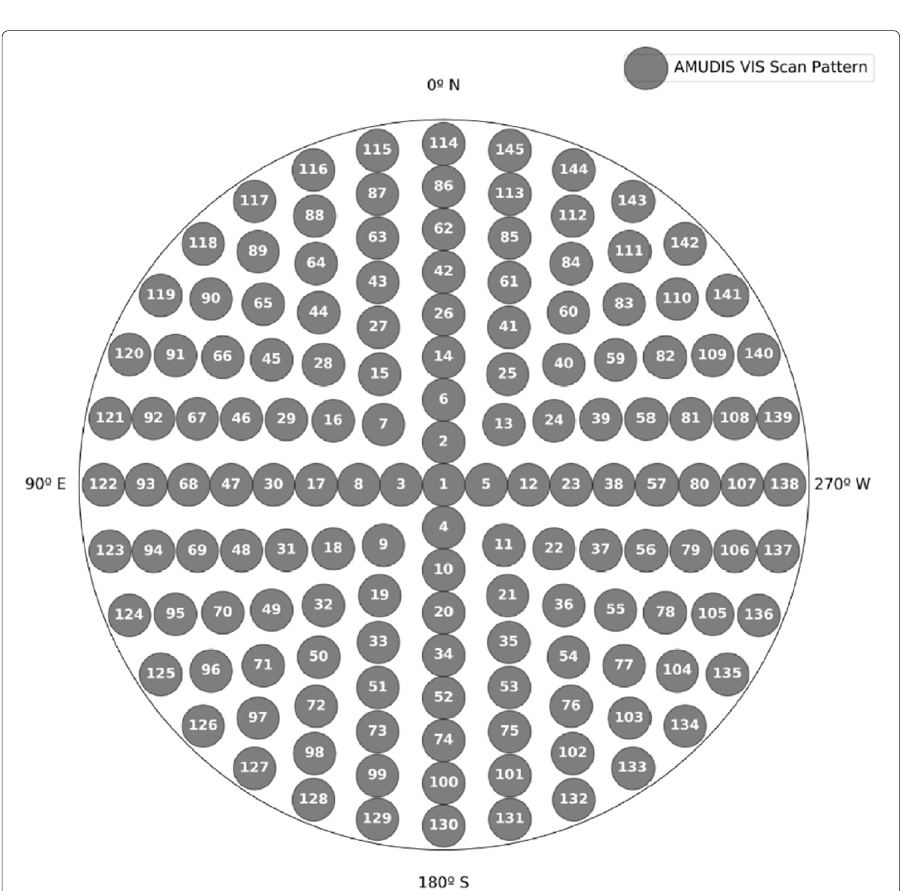
Fig. 2 Channels of the AMUDIS entrance optics. Each channel has associated a pixel value in the corresponding CCD sensor of the